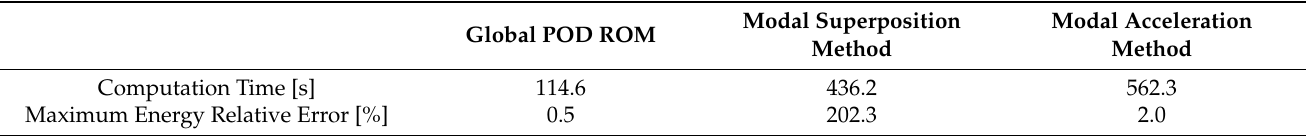
Table 1. The computation time and the maximum energy relative error of the initial configuration frequency response analysis using different methods.